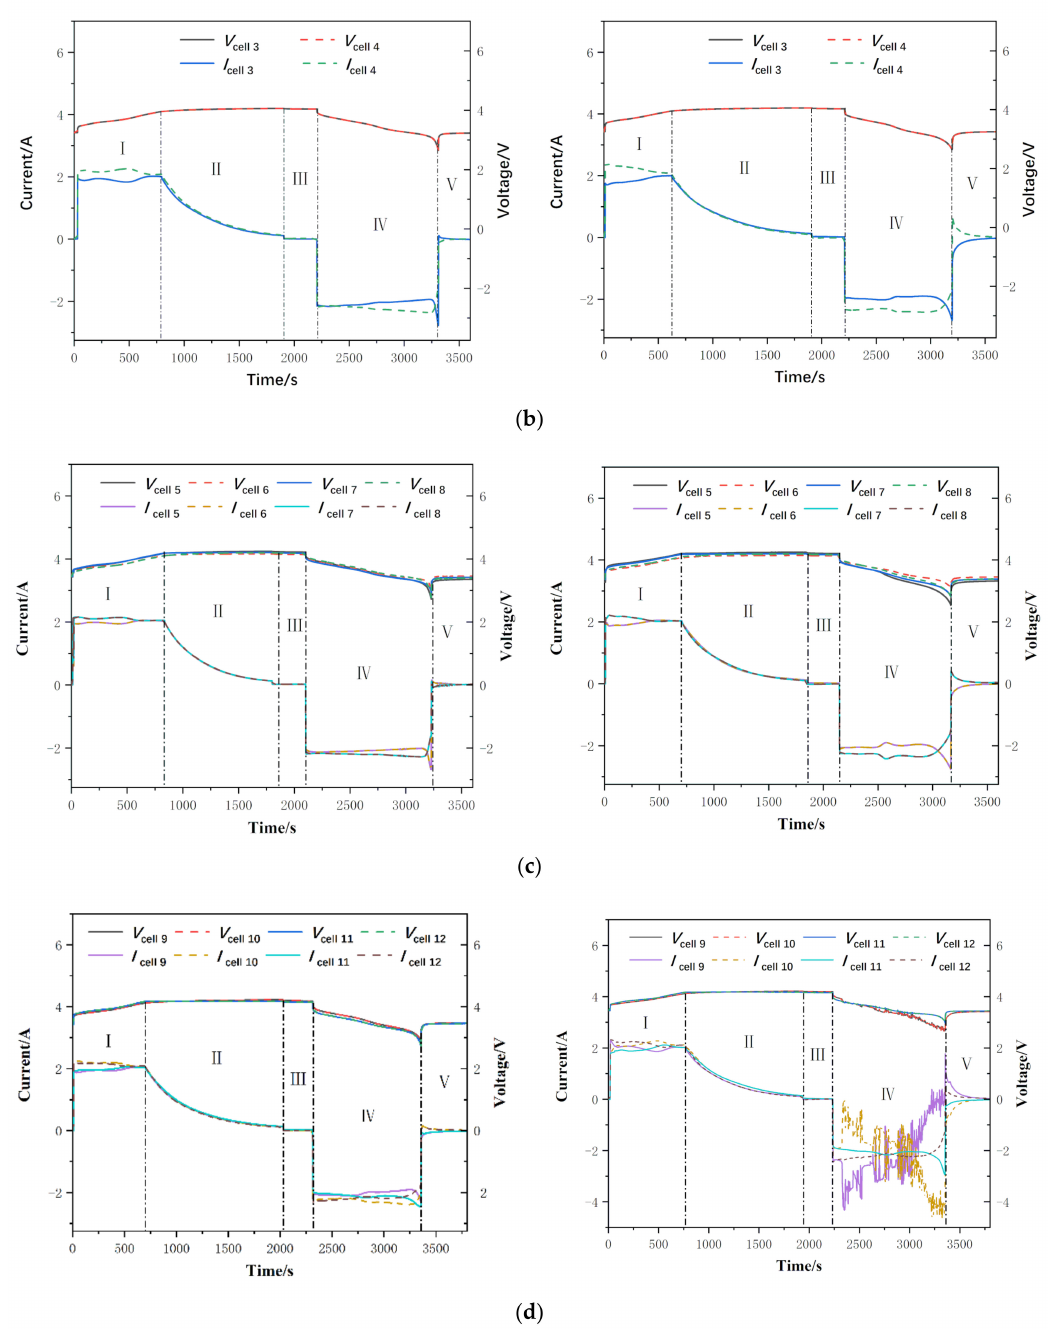
Figure 4. Comparison of charge and discharge profiles between cycle 5 and cycle 95: ( a ) Pack A; ( b ) Pack B; ( c ) Pack C; ( d ) Pack